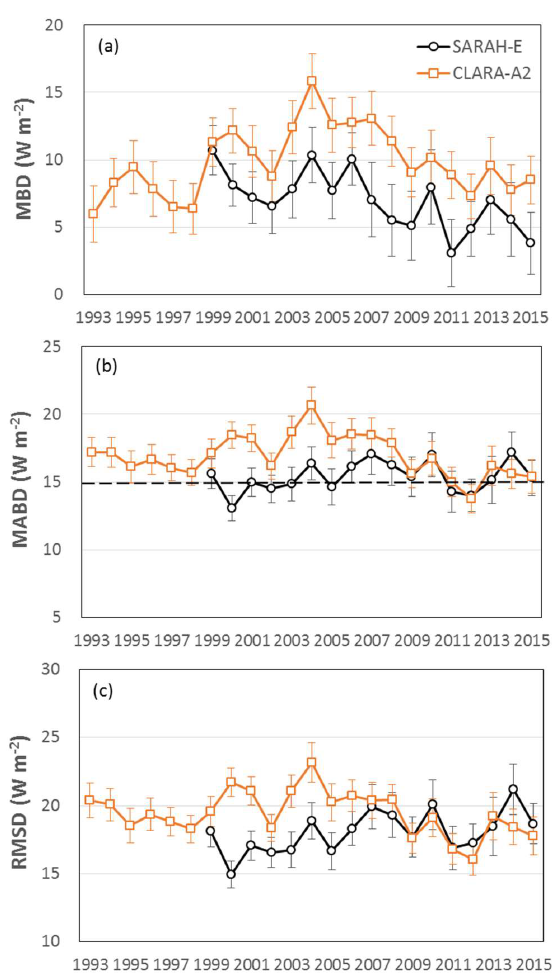
Figure 7. Annual variations of MBD (Mean Bias Deviation, ( a )), MABD (Mean Absolute Bias Deviation, ( b )) and RMSD (Root Mean Square Deviation, ( c )) in W m −2 for the CLARA-A2 and SARAH-E radiation datasets for 1993–2015. The bars on the points are the standard errors of the annual means. The dashed line in subfigure B indicates the accuracy threshold.